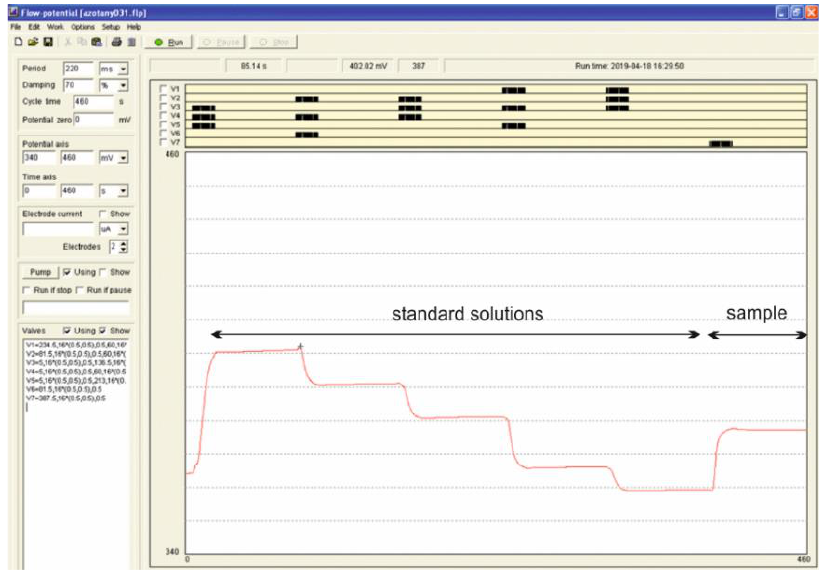
Figure 3. Editing window of the computer program used in this research. Program of micro-pumps for one measuring cycle (top) and corresponding voltage signal of ISE as a function of time (red line-bottom).